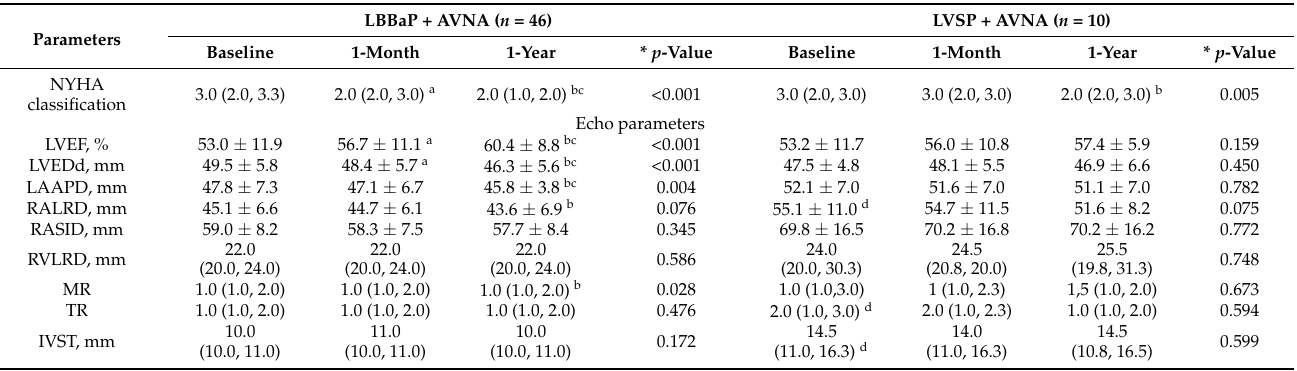
Table 4. Comparison of NYHA classifications and echocardiographic parameters (( (IQR, 25–75%)).